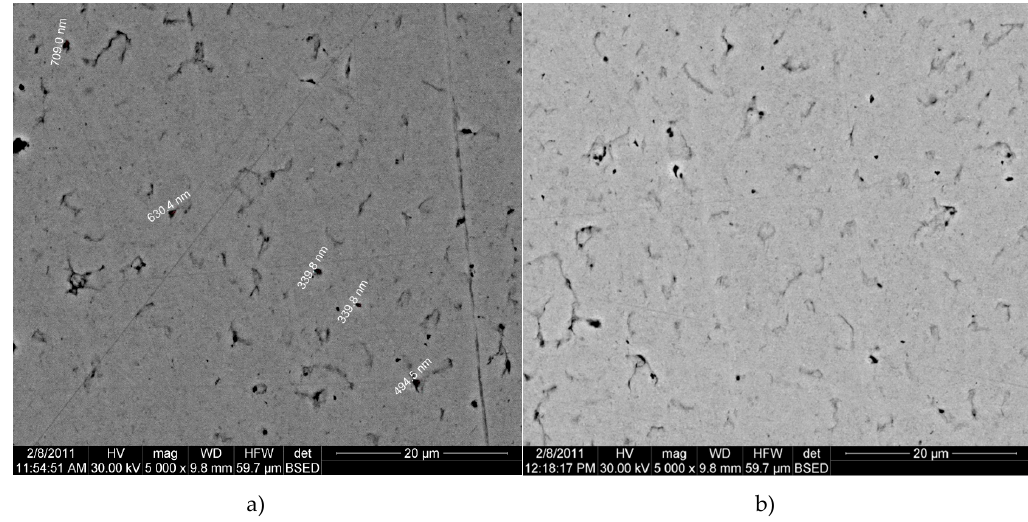
Figure 14. BSED microscopy images of Cu-15%Fe 3 O 4 nanocomposite obtained by sintering at 650 °C for 60 min ( a ) and 75 min ( b ).